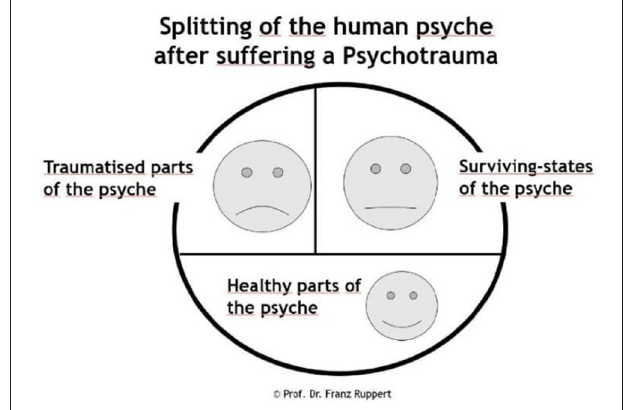
FIGURE 1 | Model of Split of the human psyche after suffering a psychotrauma by